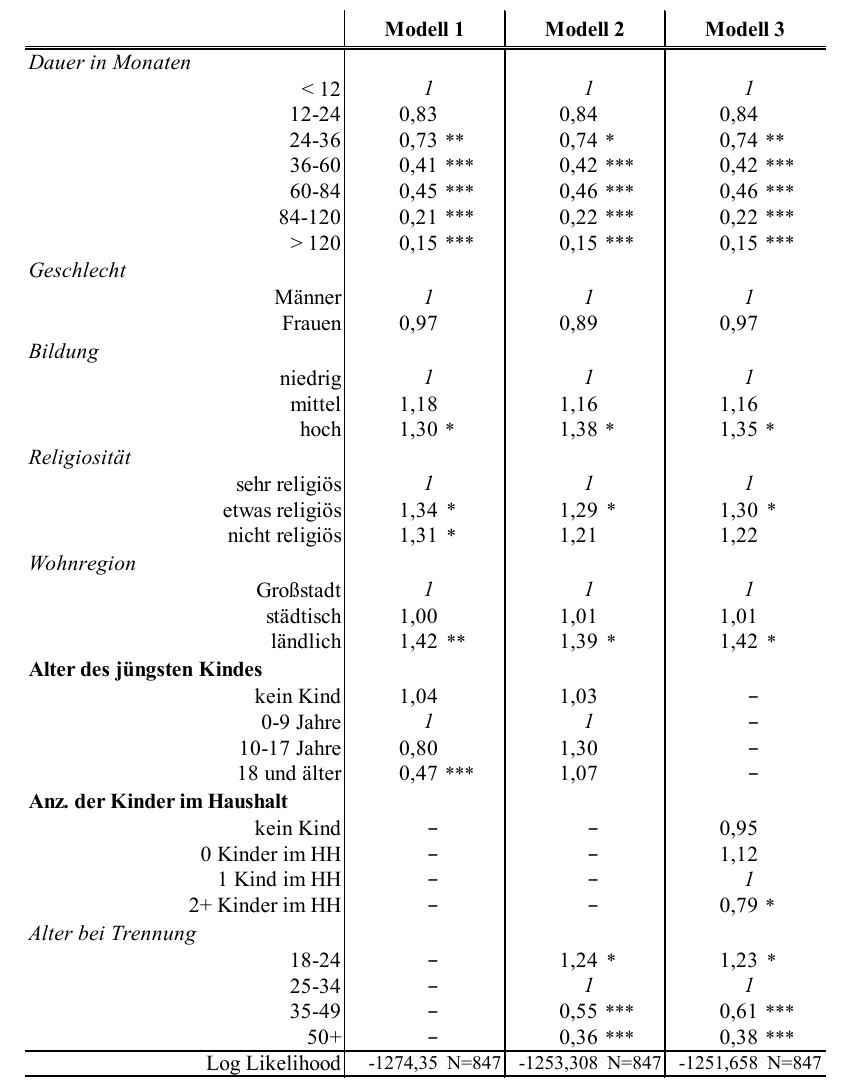
Tabelle 1: Relative Risiken des Übergangs in eine nacheheliche Partnerschaft, Ergebnisse des